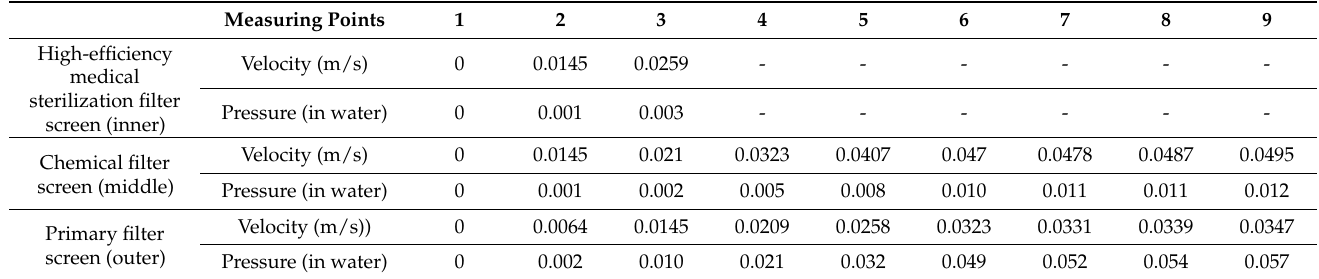
Figure 15. Primary filter screen. Table 2. Air purifier filter screen pressure and air volume. Table 2. Air purifier filter screen pressure and air volume.